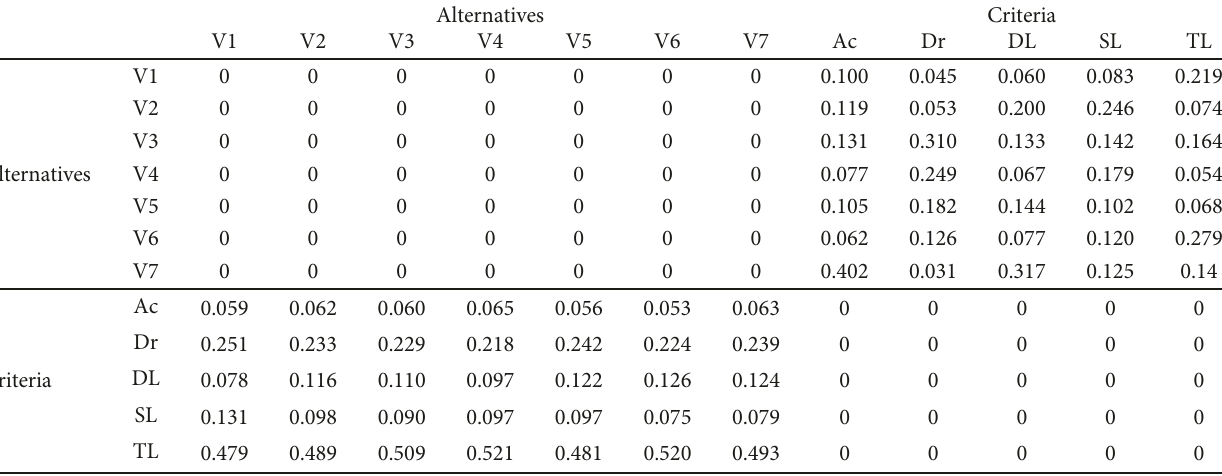
Table 6: Weighted